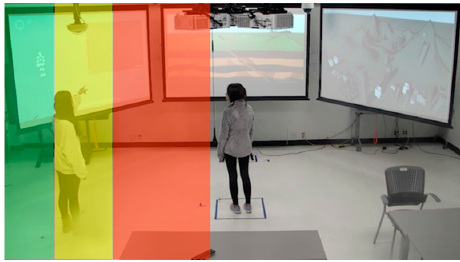
in Figure 4: “green” (far), “yellow” (mid), or “red” (near). The reference frame zones were determined based on initial video observations and were designed to keep a radius of consistent proximity from left to right of the student and distance from the simulation screens. All of the Datavyu codes were exported using video frame time codes for further analysis.